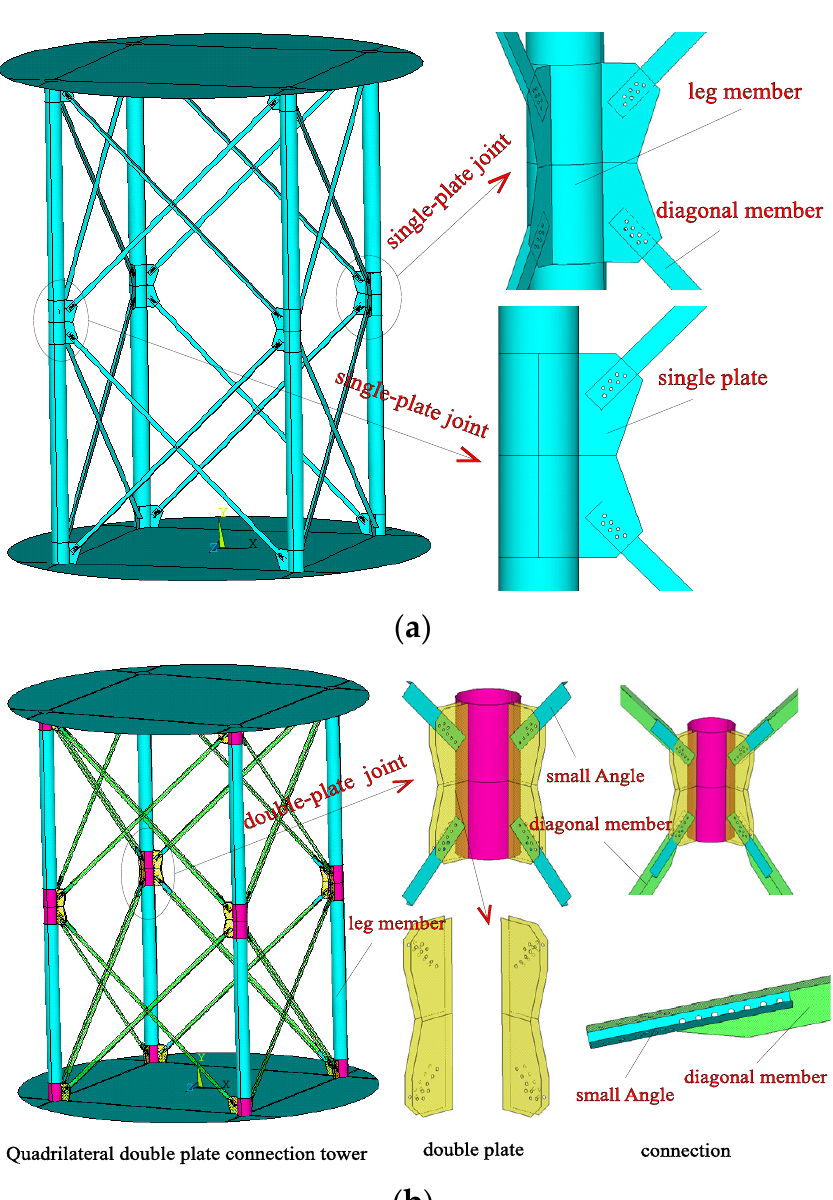
Figure 15. ( a ) Geometric model of quadrilateral tower with SLSPJ; ( b ) geometric model of quadrilateral tower with DLDPJ.